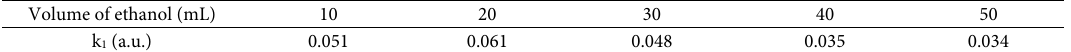
and calcined different 2